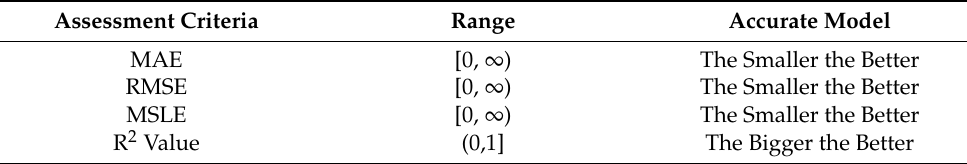
Table 6. Range of Errors for Statistical Parameters [91]